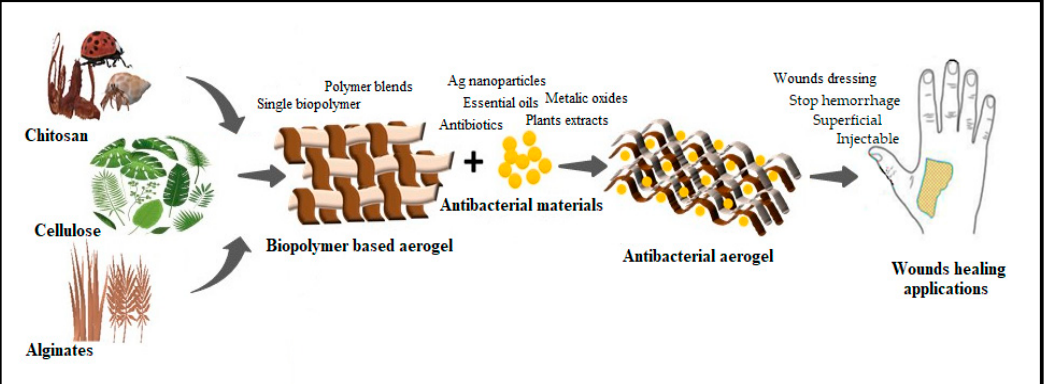
Figure 5. Schematic drawing of biopolymers antibacterial aerogels.